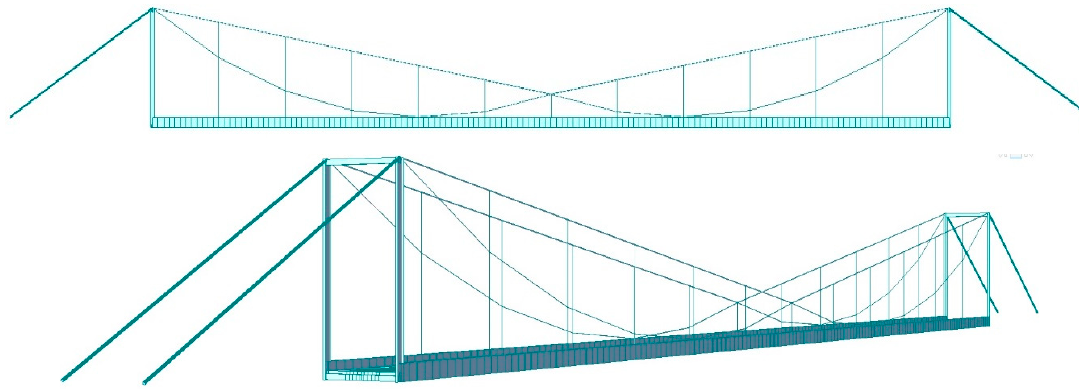
Figure 3. Sketches of a finite-element model of a suspension hybrid bridge.